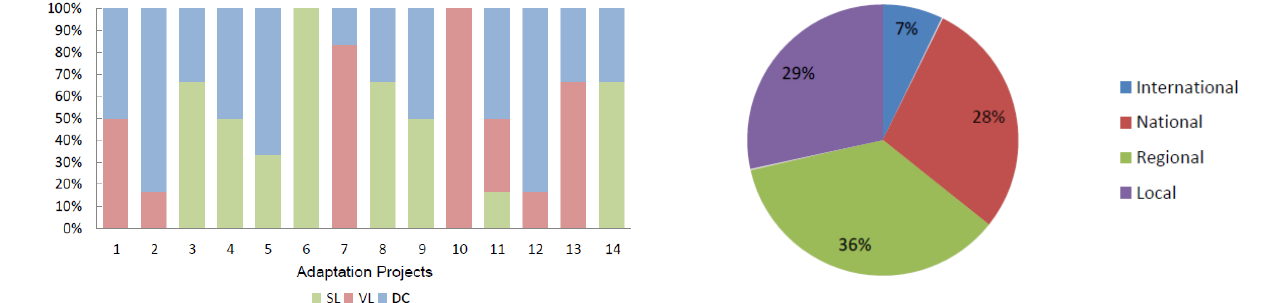
Figure 7. Relative regional scales of adaptation schemes surveyed in the nuclear neighbourhood.